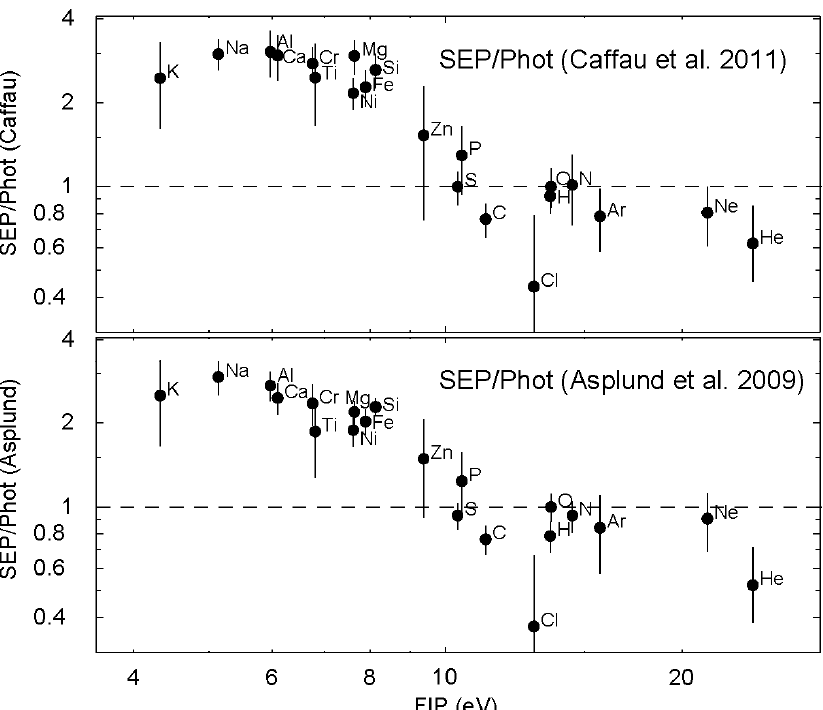
Figure 2. Average solar energetic particle (SEP) abundances [52,58,59] divided by corresponding photospheric abundances are plotted vs. first ionization potential (FIP) comparing photospheric abundances of Asplund et al. [60] ( lower panel ) and Ca ff au et al. [61,62] ( upper panel ). See Appendix A for numerical values.